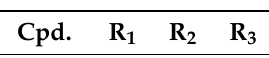
Figure 51. Structure of compound 245 .